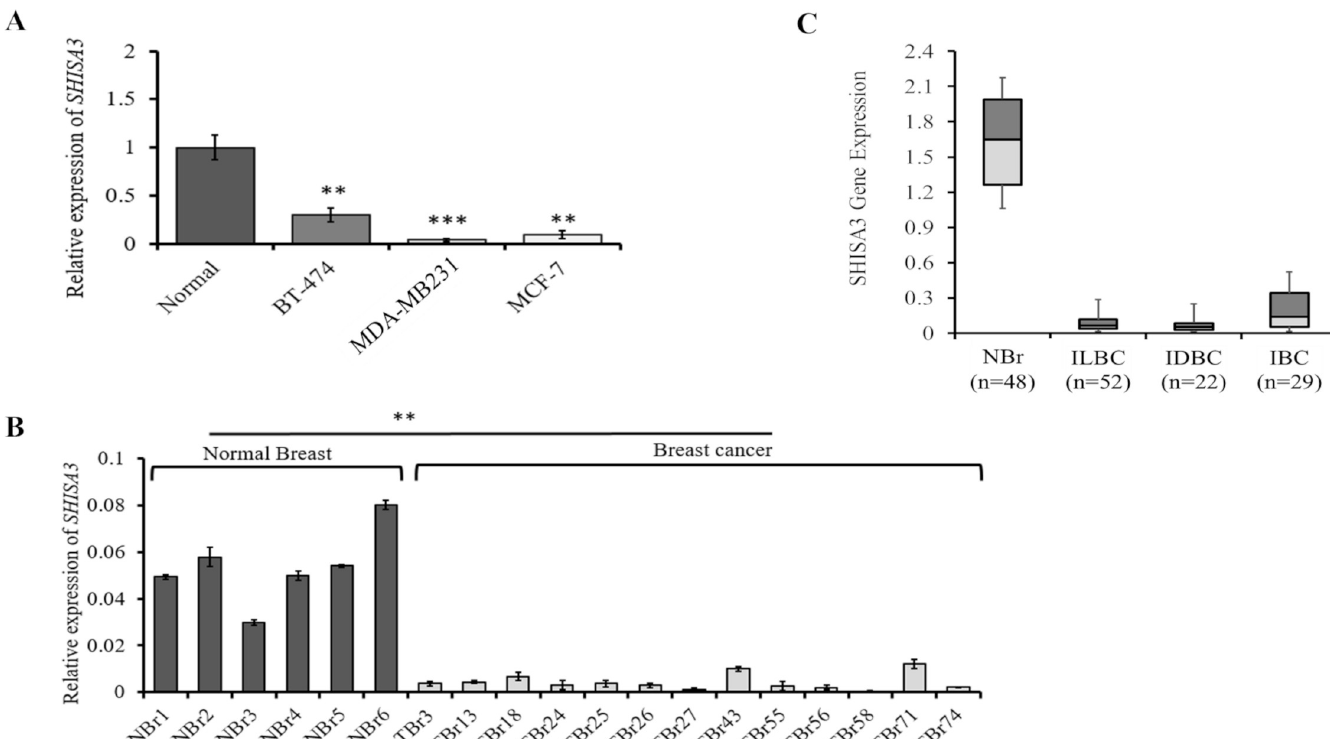
Fig 1. Expression analysis of SHISA3 in breast cancer. The mRNA levels of SHISA3 were quantified by qPCR and in silico analysis. A) The figure shows relative expression of the SHISA3 in the normal cells and breast cancer cell lines. B) The bar graphs show the relative expression of the SHISA3 genes in the normal breast (NBr) and tumor (TBr) tissues. C) In silico analysis of SHISA3 expression levels in normal and various breast cancer subtypes. IBC: Invasive Basal Carcinoma, ILBC: Invasive Lobular Carcinoma, IDBC: Invasive Ductal Carcinoma and NBr: normal breast tissues.